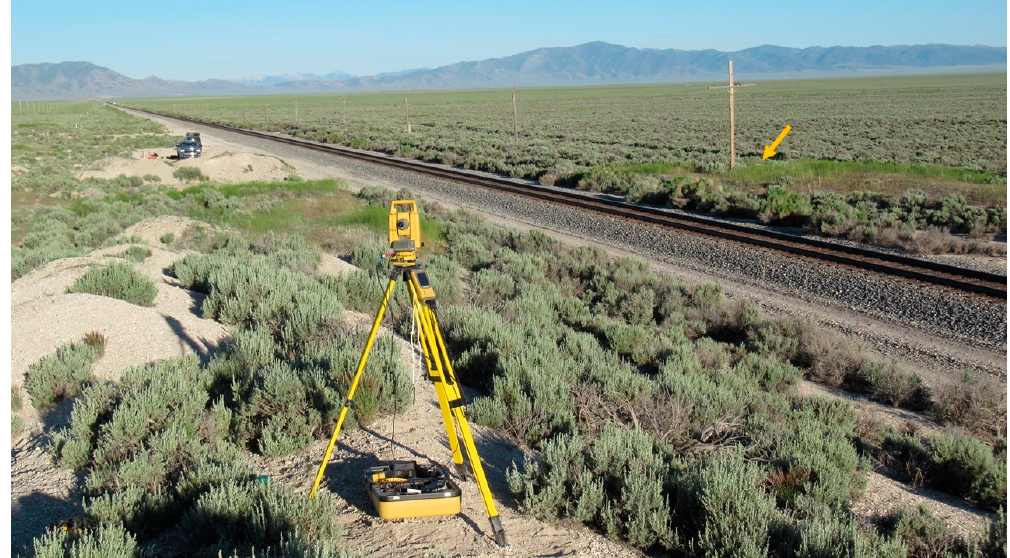
Figure 4 . Site where the laser total station was installed for surveying Transects A and B. The vertical other side of the railroad line (orange arrow).